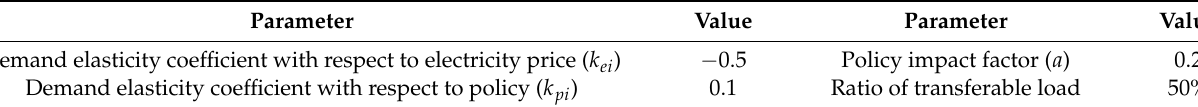
Table A7. Parameters of demand response model.